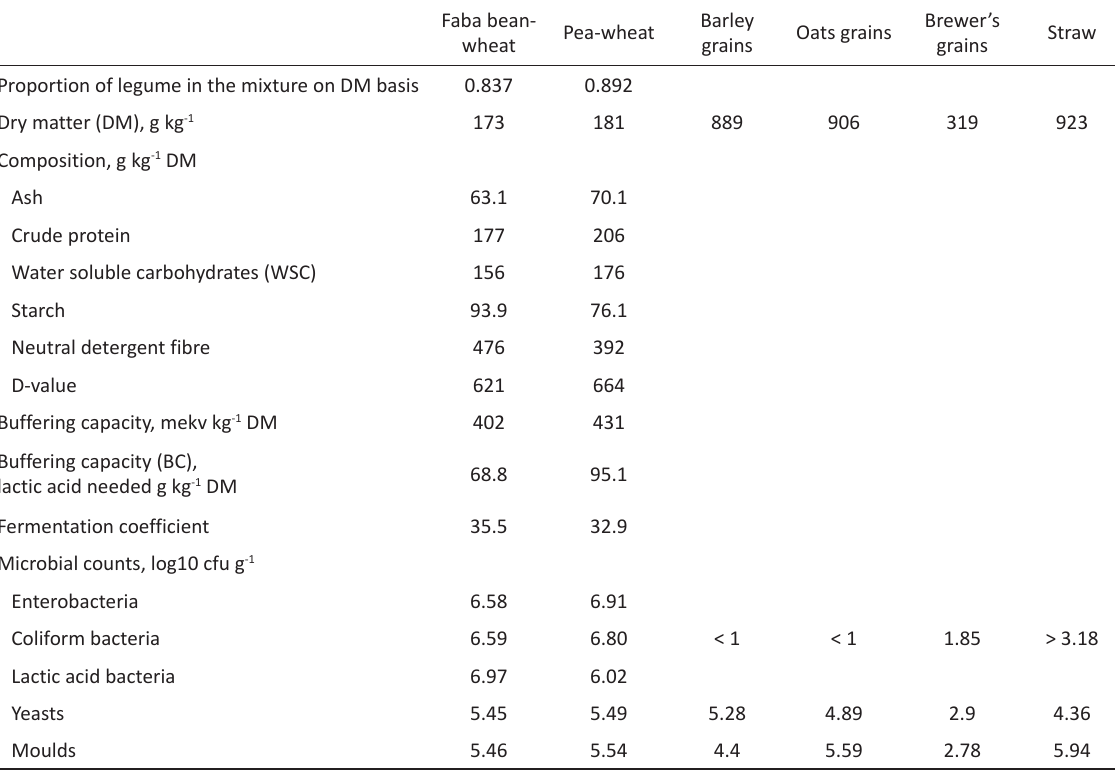
Table 2. Chemical composition and microbial quality of the whole crops prior to ensiling and concentrate feed components used for total mixed ratios in aerobic stability tests